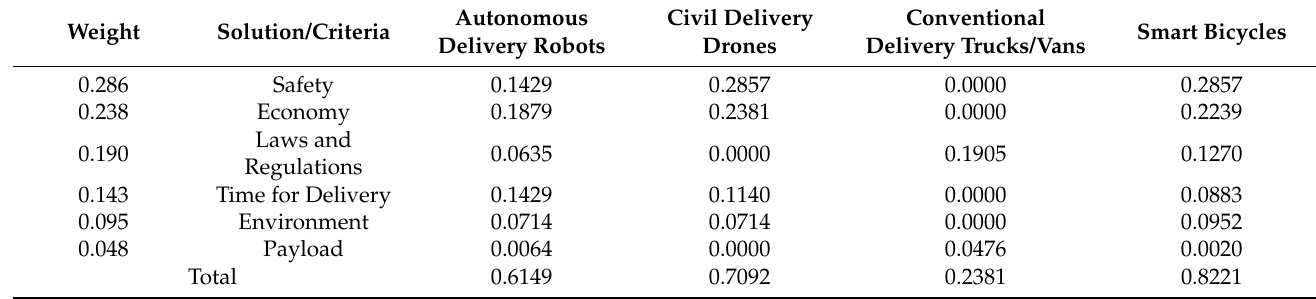
Table 14. Total scores, rank sum method—in the case of